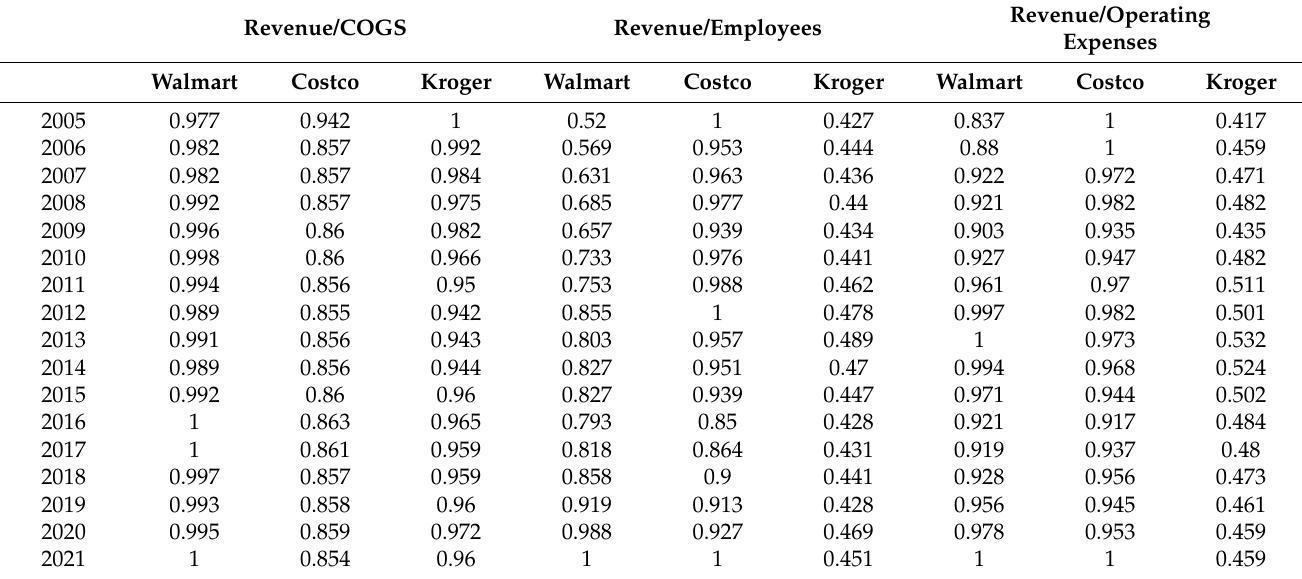
Table 9. Operational efficiencies for top three US retailers.